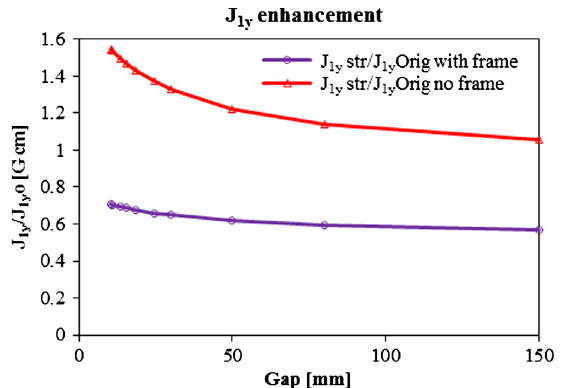
FIG. 11. Vertical Earth ’ s field ( B y ¼ − 0 . 4 gauss) enhancement vs gap in the cases with a frame and without it. Calculations are for APS27 #5s.